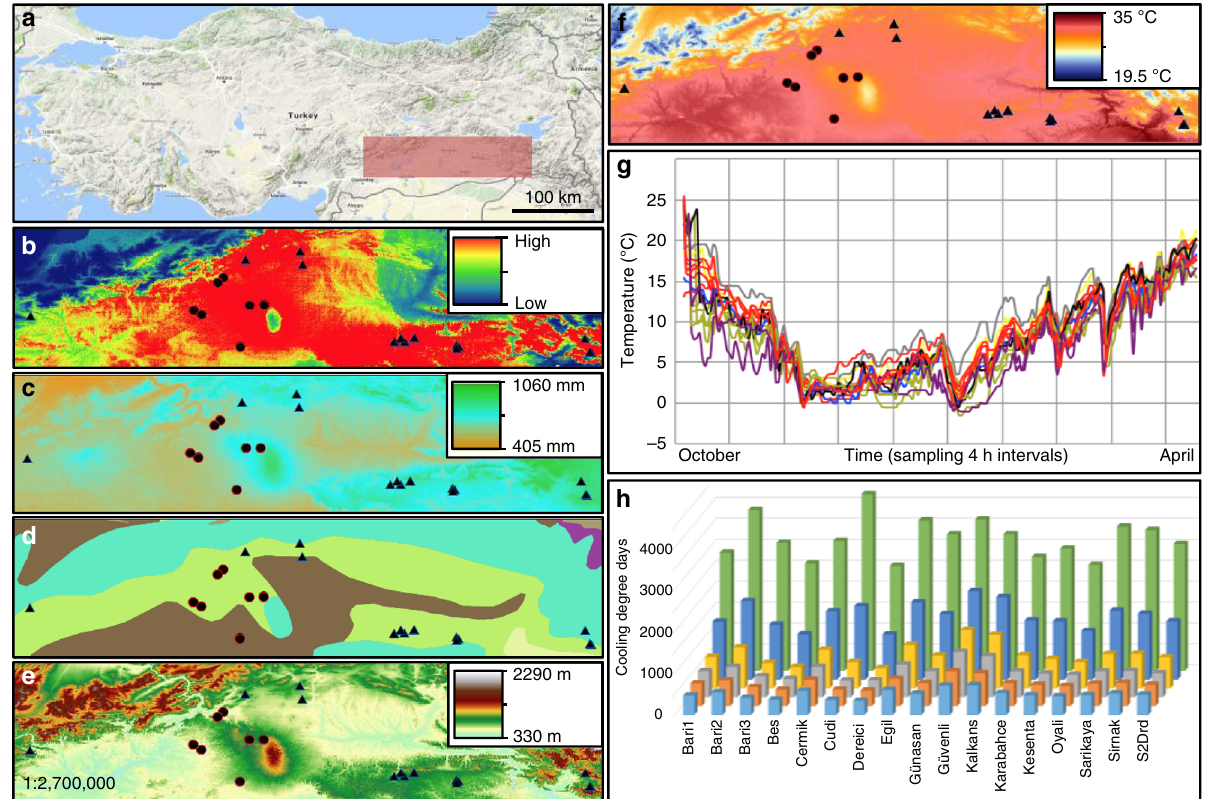
Fig. 1 Environmental variation across the native range of the wild relatives of chickpea. a Topographic map of Turkey with the collection region featured in b – f highlighted in red. Map data obtained from @2018 Google, ORION-ME. b Bioclimatic model of the likelihood of species distribution, combined for both C. reticulatum — black rectangle and C. echinospermum — black circles. c Total annual precipitation across southeastern Anatolia. d Major soil types: Calcisols — brown circles; Kastanozems — purple circles; Leptosols — blue-green circles; Luvisols — lime-green circles; Vertisols — yellow circles. e Elevation across southeastern Anatolia. f Summer maximum temperature in southeastern Anatolia. Panels b – f were generated using Maxent open-source software 61 . g Variation across collection sites in maximum temperature, recorded at 4 h intervals 5 cm below the soil surface with ibutton data loggers. Data are shown for 22 October 2013 through 21 April 2014, which encompasses winter and through late vegetative growth of the wild species. h Modi fi ed photo-thermal units (i.e., cooling degree days) at each site integrated over the growing season from 1 November 2013 until 15 May 2014. November — light blue squares; December — orange squares; January — gray squares; February — yellow squares; March — blue squares; April – May — green